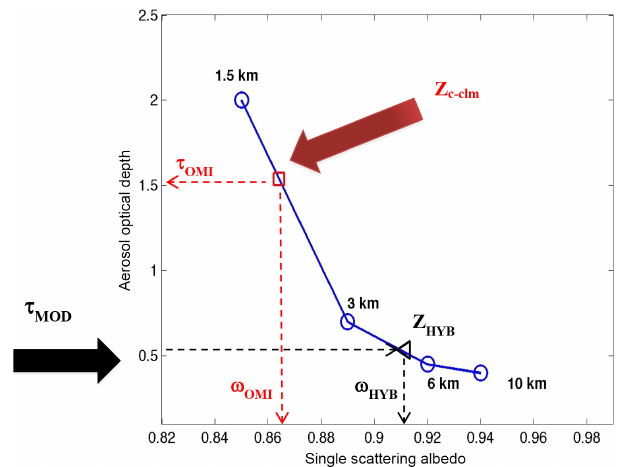
Figure 1. Illustration of the standard (or operational) and hybrid (Satheesh et al., 2009) retrieval schemes. The OMAERUV algo- rithm computes the pair of AOD and SSA at four assumed aerosol heights for the pixel’s viewing geometry (blue solid lines and cir- cles). In a prior step, it selected an aerosol model and surface albedo used in the computation. Each triplet (height, SSA and AOD) has a corresponding upwelling radiance matching the observed radiance by OMI. To select the final (or retrieved) aerosol height and SSA for the pixel, the standard (OMAERUV) algorithm uses a climatolog- ical height ( Z c − clm ) to determine the final AOD and SSA (red ar- row and red dashed lines). The hybrid method uses a MODIS AOD (extrapolated to 388nm) as the entry point (black arrow and black dashed lines) to determine the Z and SSA using the triplets from the lookup